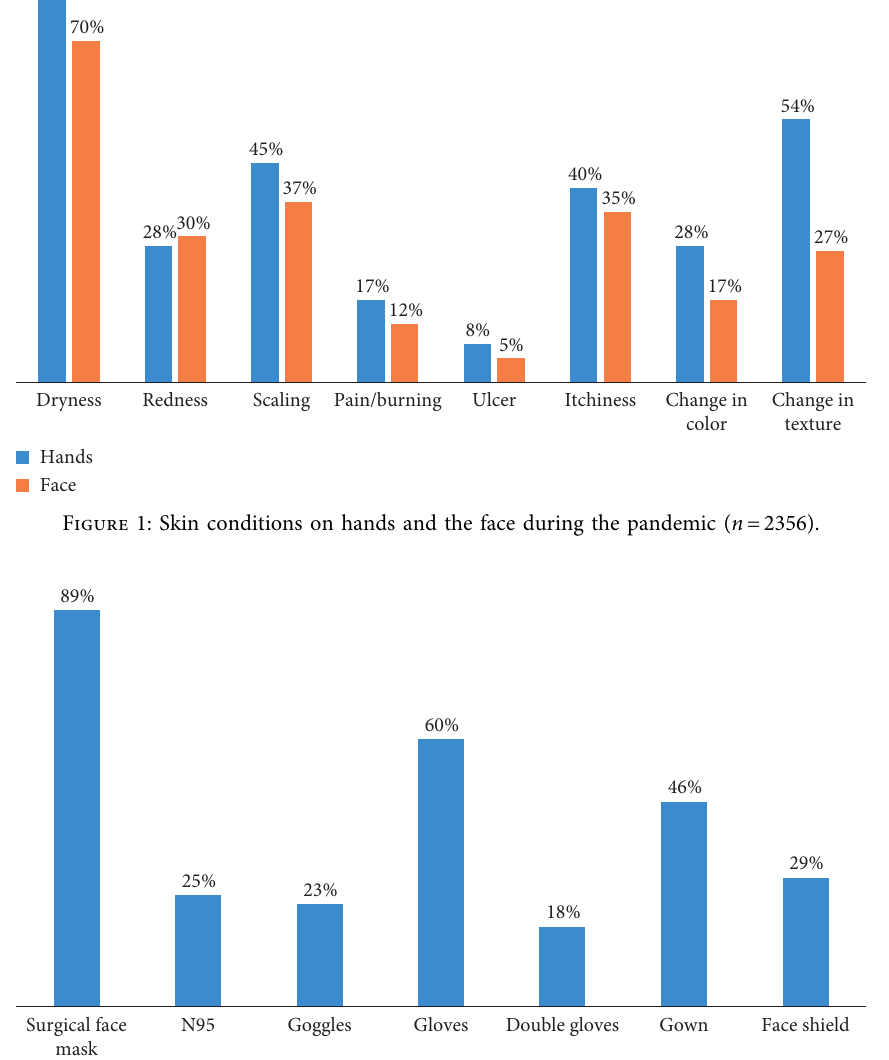
Figure 2: PPE used by healthcare workers during the pandemic ( n �